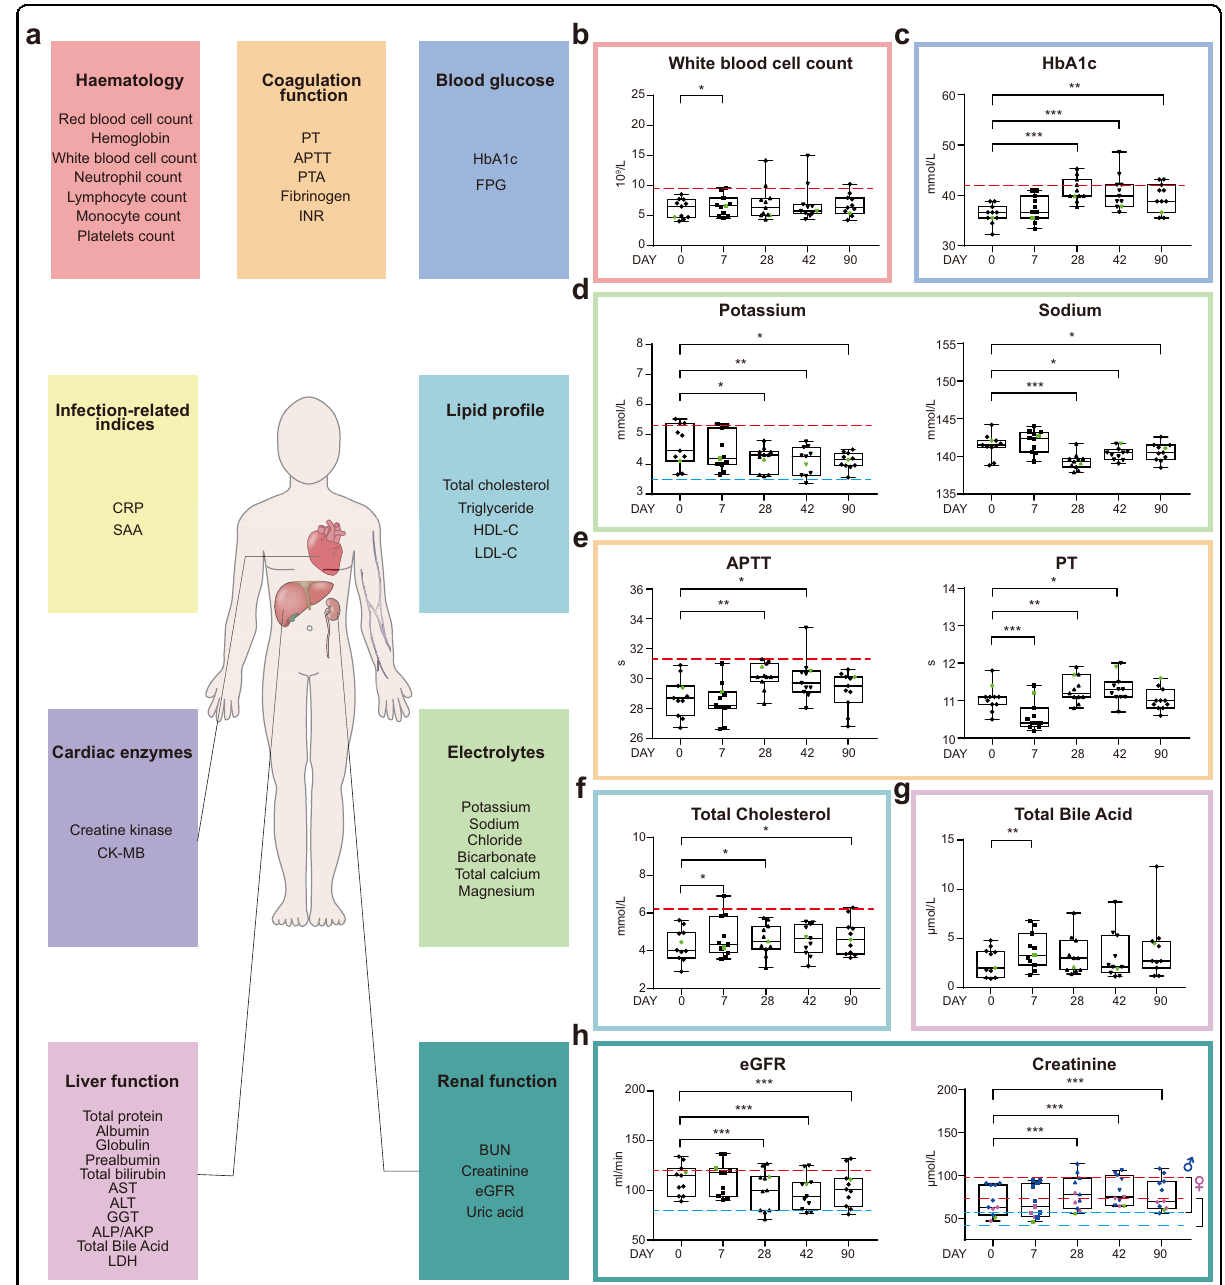
Fig. 2 Temporal changes of clinical laboratory measurements after vaccination. a Clinical laboratory routine tests include hematologic and coagulation parameters, blood glucose-related and infection-related indices, lipid pro fi le, cardiac enzymes, electrolytes, liver- and renal function- related biomarkers. More information could be found in Supplementary Tables S4 and S5. Laboratory test values of white blood cell count ( b ), HbA1c ( c ), potassium ( d , left panel), sodium ( d , right panel), APTT ( e , left panel), PT ( e , right panel), total cholesterol ( f ), total bile acid ( g ), eGFR ( h , left panel), creatinine ( h , right panel). Data points represent the values of each individual. Box plots showed the 25th, 50th (median), and 75th percentiles. Horizontal dashed lines showed upper normal limits (red) in b , c , d (left panels), e (left panel), f , h and the lower normal limits (blue) in d (left panel) and h . The P values were calculated by the Wilcoxon sign-rank test by comparing the laboratory measurements at each time with the baseline measurements. * P ≤ 0.05, ** P ≤ 0.01, *** P ≤